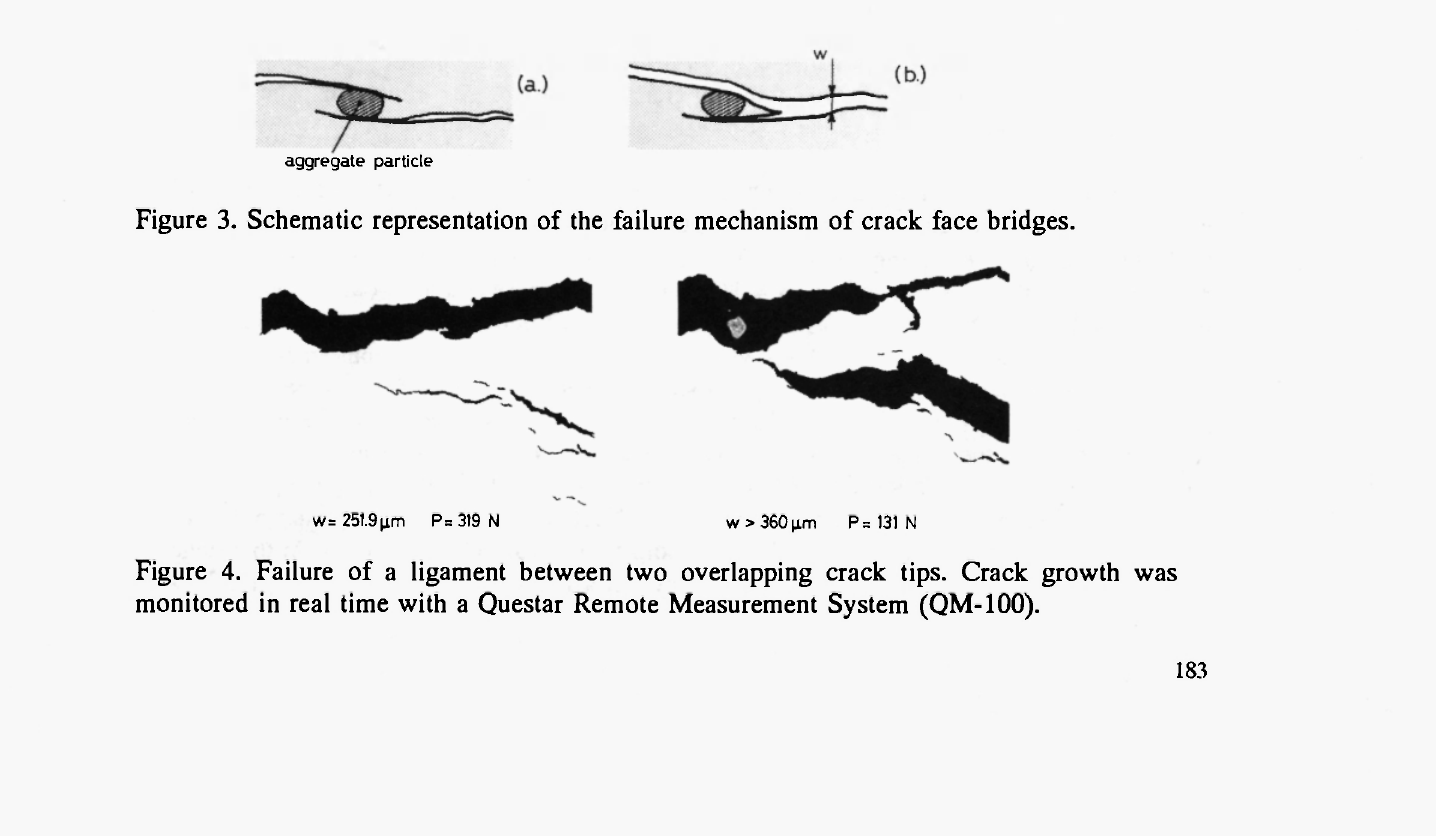
Figure 3. Schematic representation of the failure mechanism of crack face bridges.